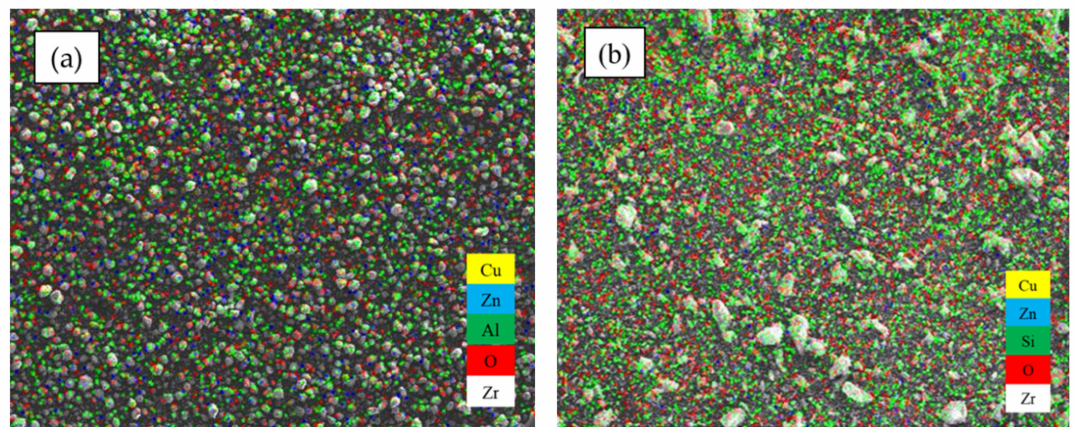
Figure 4. EDX mapping of ( a ) CZMNZA ( b )